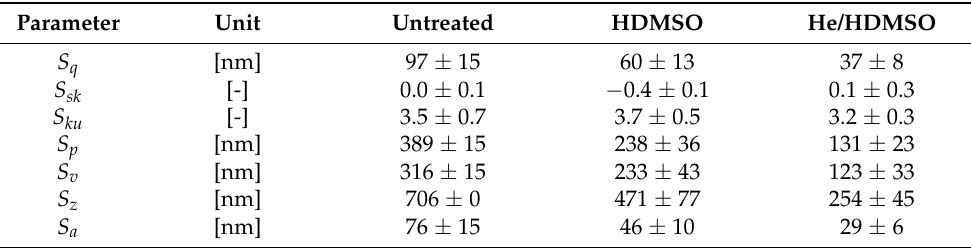
Table 2. Height surface parameters of the untreated and treated starch films, according to ISO 25178-2:2012, (n =